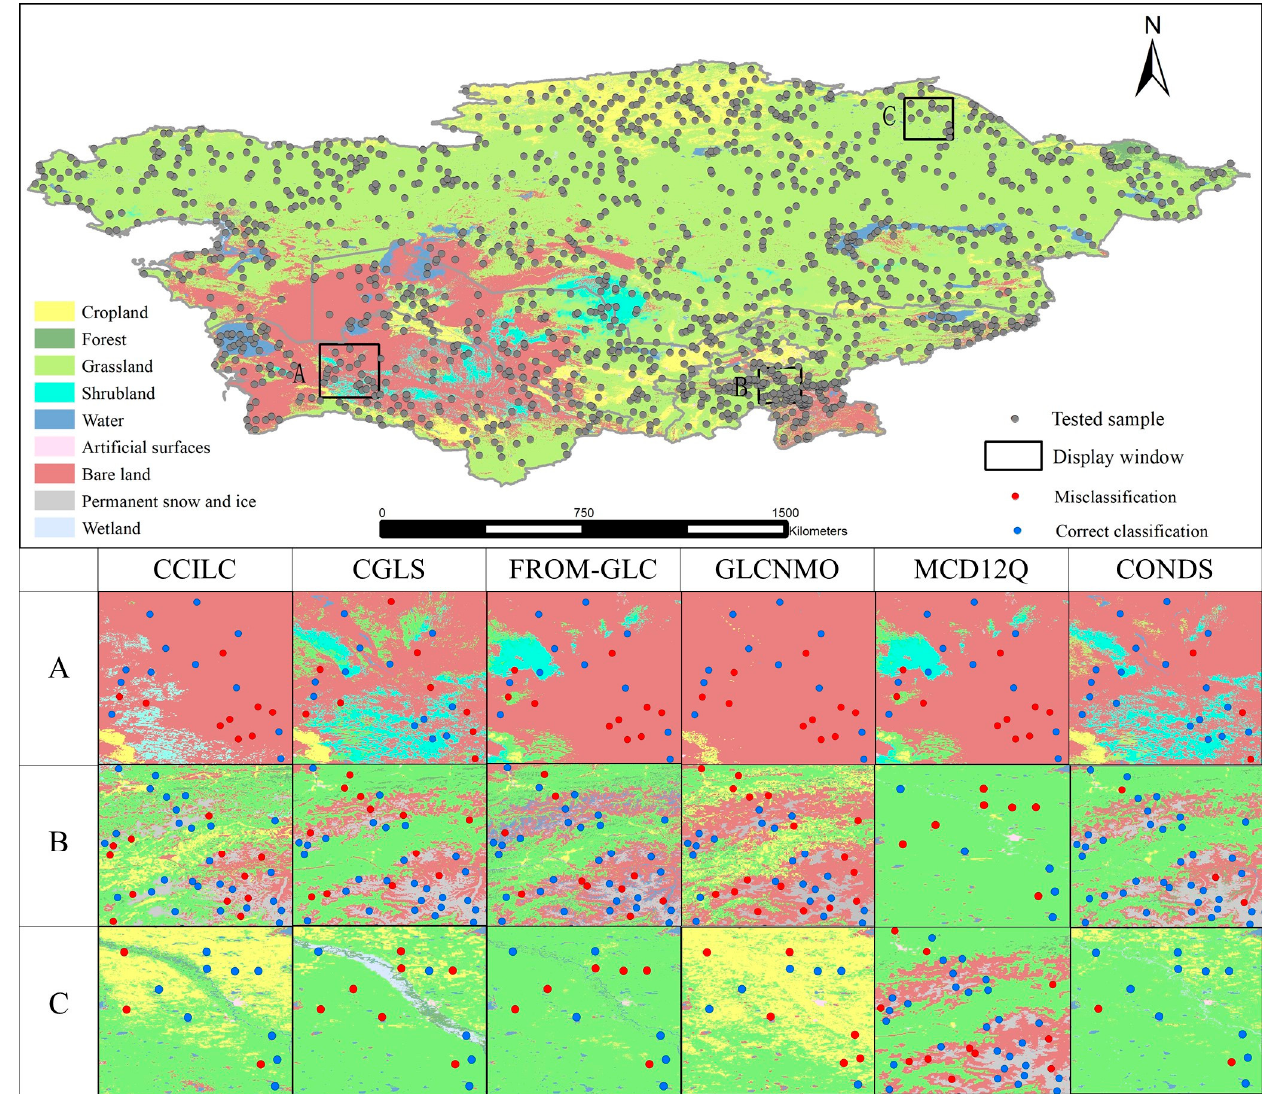
Figure 11. Spatial distribution of accuracy test for multiple landcover products and fusion results. ( A ) Karakum Desert; ( B ) Pamirs Plateau; ( C ) Turan Plain.